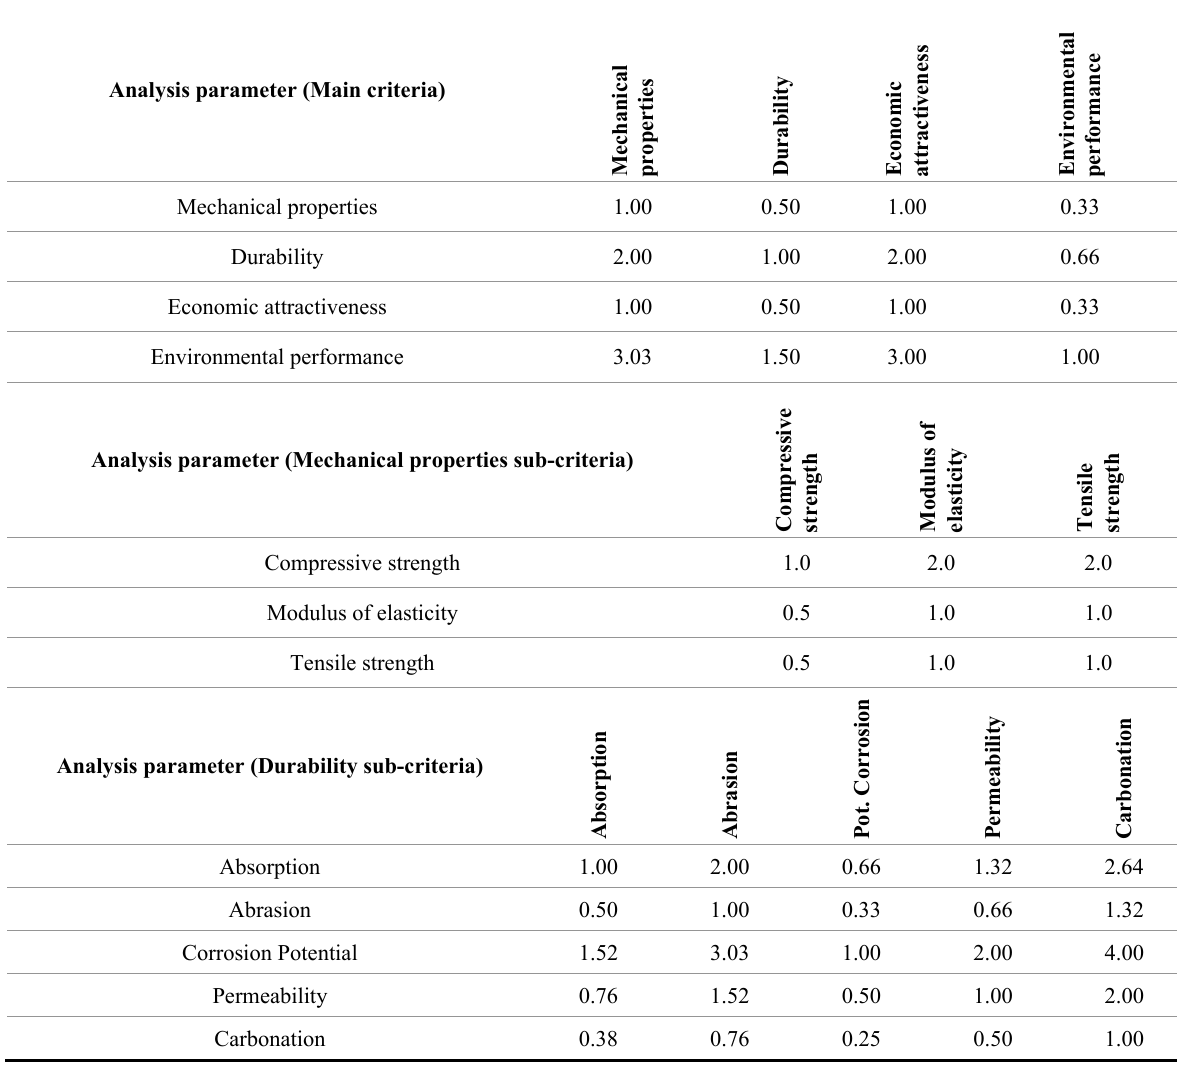
Table 6. Decision matrix of criteria, mechanical properties sub-criteria and durability sub-criteria (Scenario 3 - foundation block).